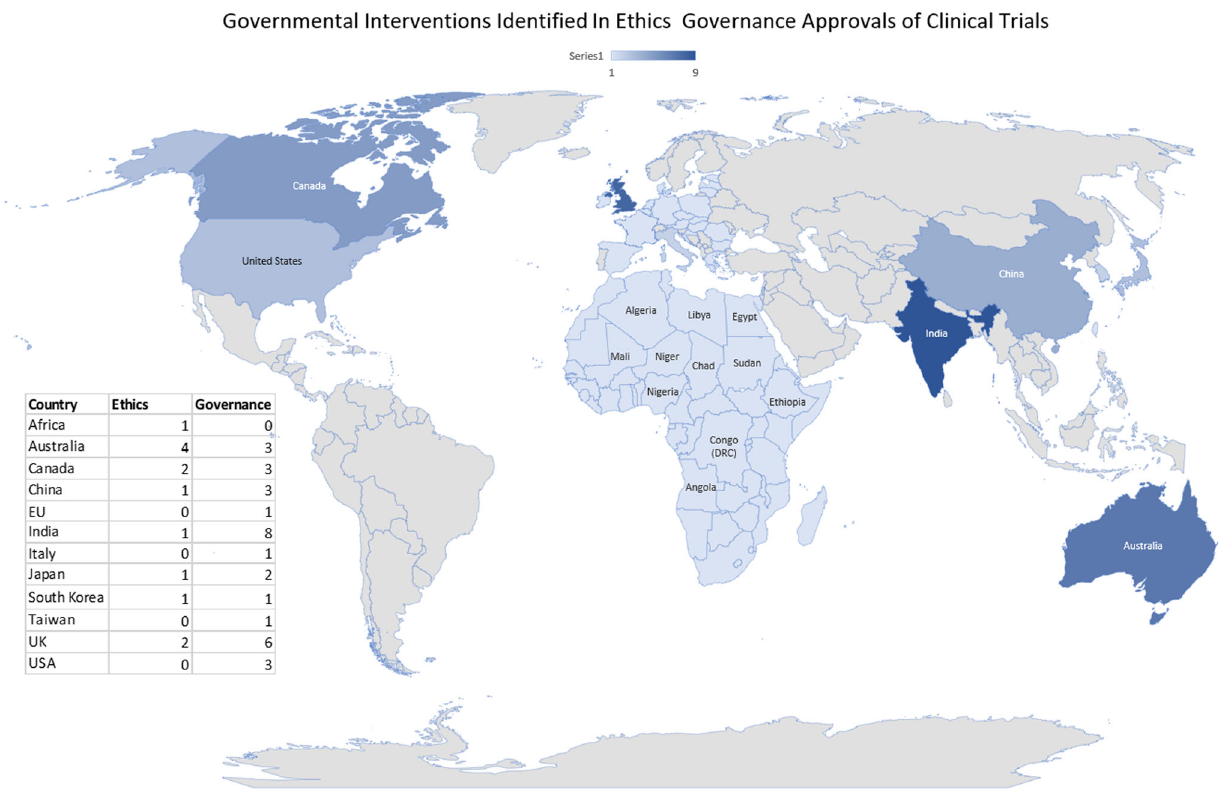
Fig. 2 Global distribution of government interventions targeting ethics review or governance processes. This fi gure shows a map of where each intervention occurred; the darker colouring indicates more